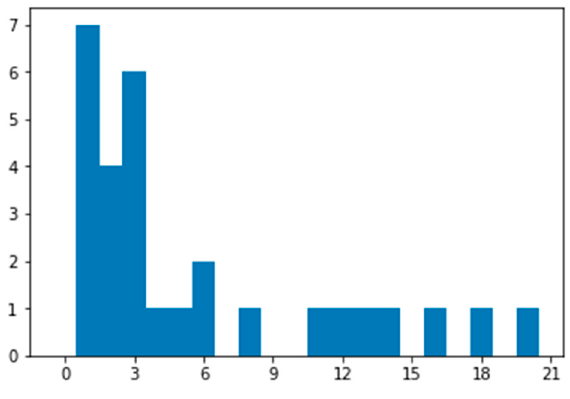
Figure 2. Numbers of additional copies for B chromosomal regions (identified by isolated chromosome sequencing) estimated based on whole-genome sequencing of the red fox individual with three Bs. Region parts with different copy numbers counted separately. Regions with copy number below three were lost from some of Bs, while regions with copy number above three were amplified within Bs. X—number of additional copies, Y—counts of regions.